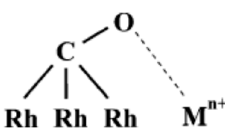
Figure 11. Schematic illustration of the tilted CO configuration on Rh / titanate catalysts. M n + represents a Ti 3 +